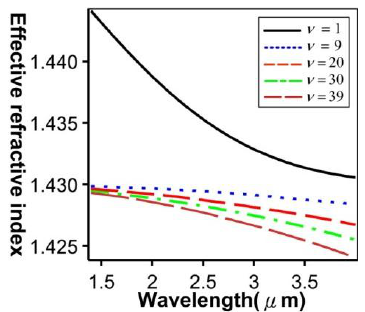
Figure 13. Relationship between the effective refractive indices and wavelengths of the guided modes (ν = 1, ν = 9, ν = 20, ν = 30, and ν = 39).